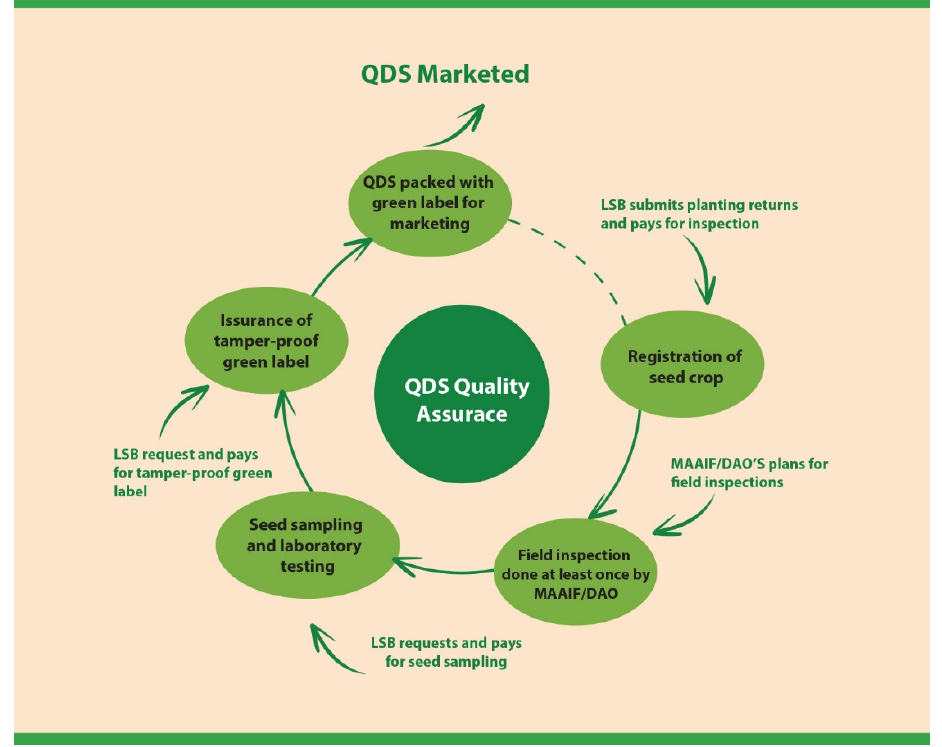
Figure 1. QDS certification cycle. Note: LSB (local seed business) is the name for QDS class producers; Source: ISSD program.